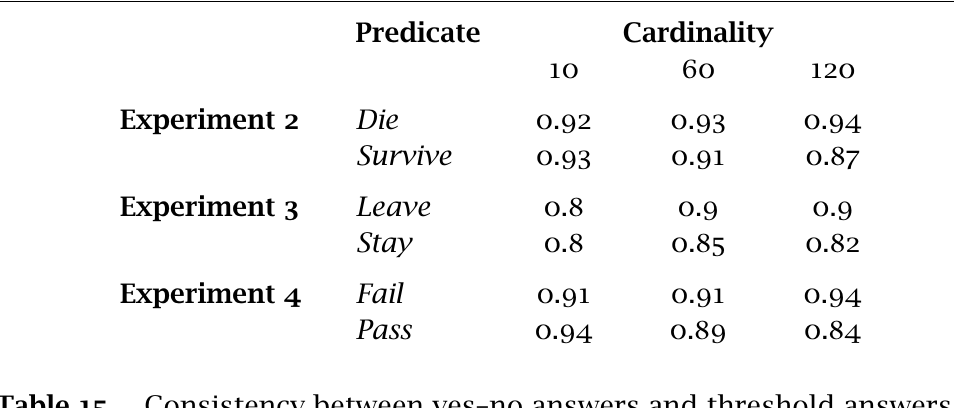
Consistency between yes–no answers and threshold answers in Experiments 2 – 4 , for each predicate and cardinality ( p < 10 − 4 in all